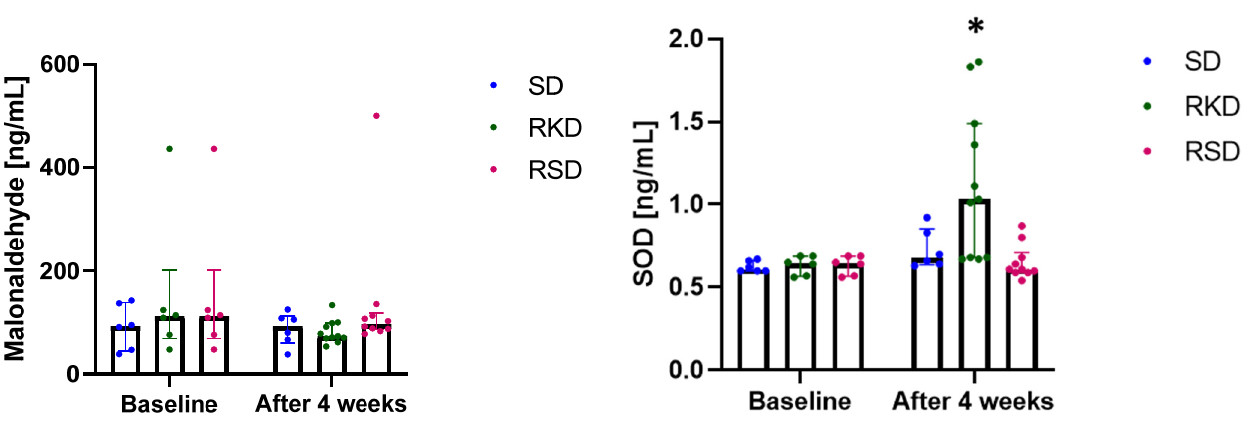
Figure 4. The status of malonaldehyde and SOD before and after the nutritional intervention. The bars represents the median with the error bars representing interquartile range (Q1; Q3). The significant differences are marked with “*”.